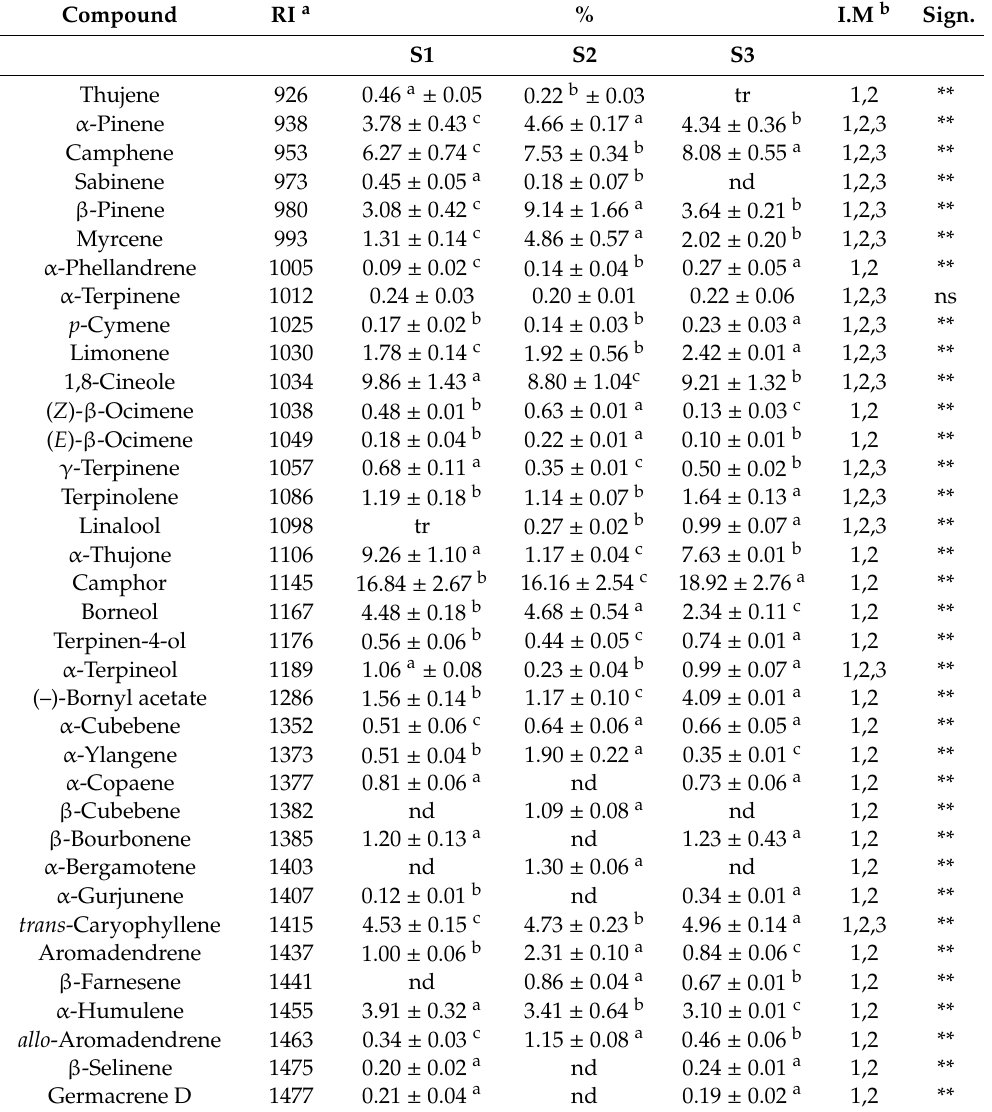
Table 1. The main identified constituents (%) of S. o ffi cinalis essential oils (EOs). Compound RI